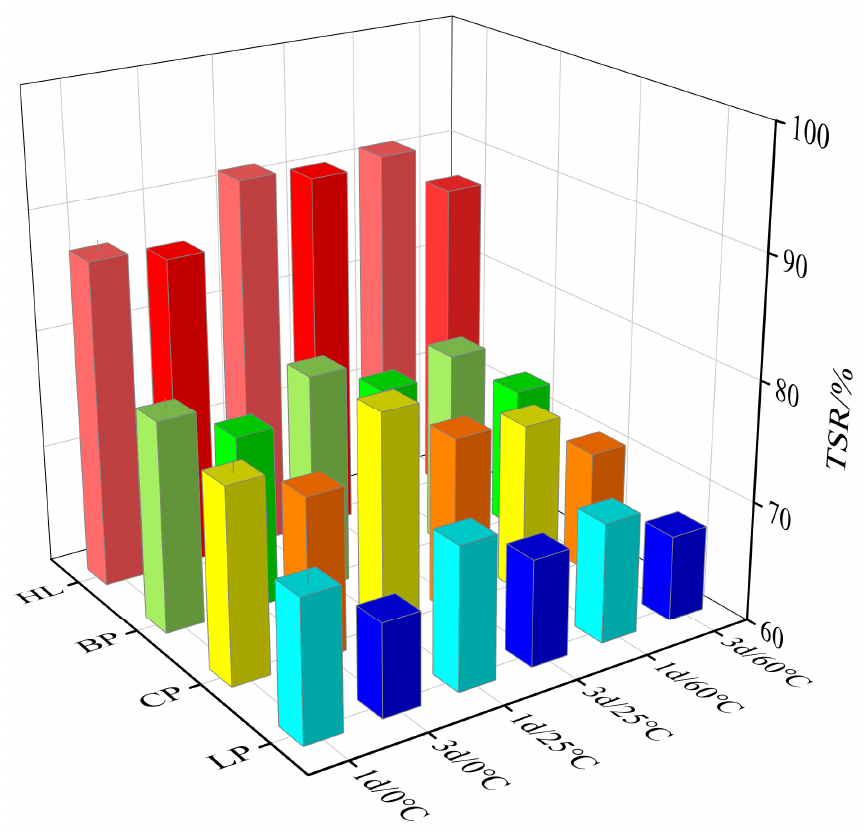
Figure 4. TSR test results of the asphalt mixtures.